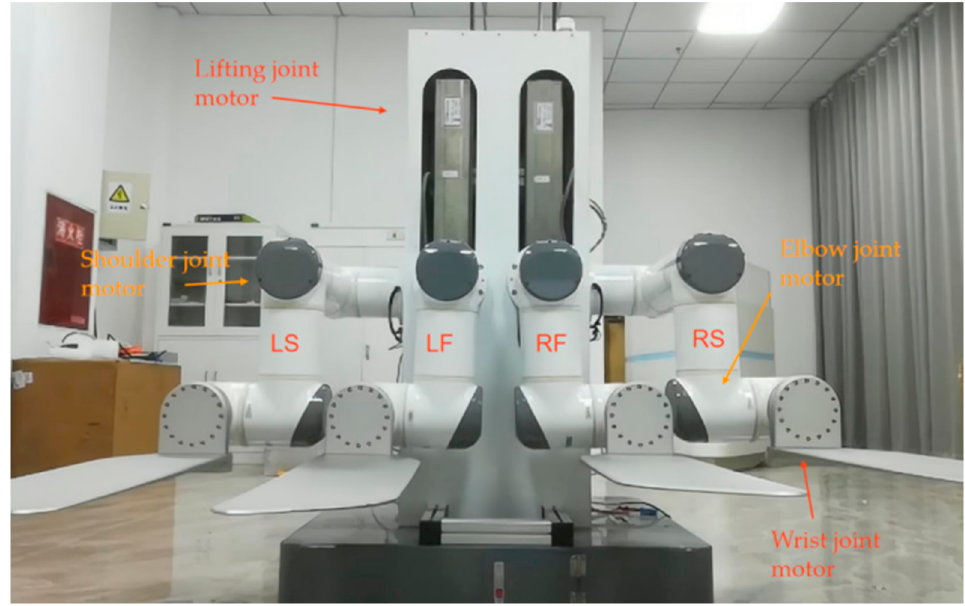
Figure 1. Front view of four-manipulator system.